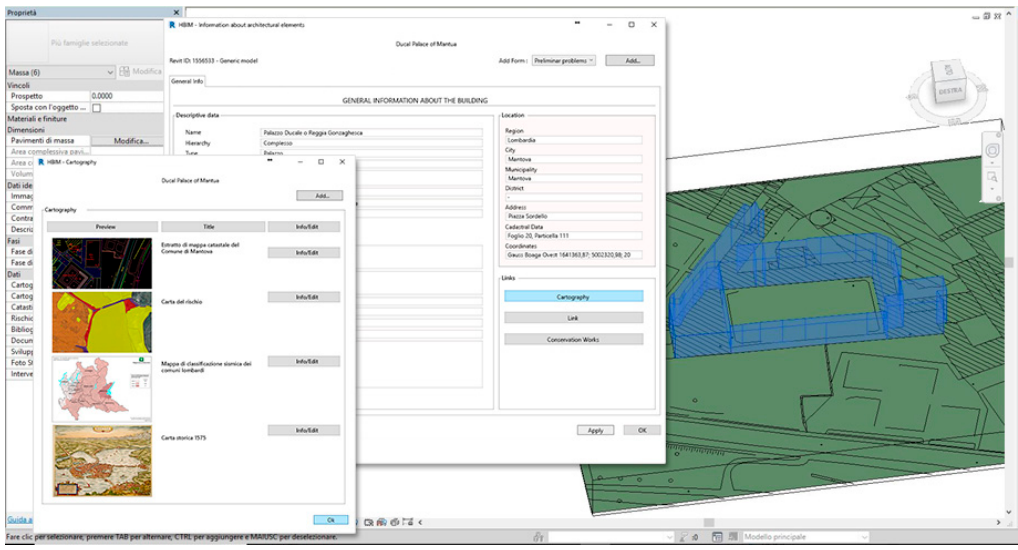
Figure 8. Graphical User Interface to access data about the